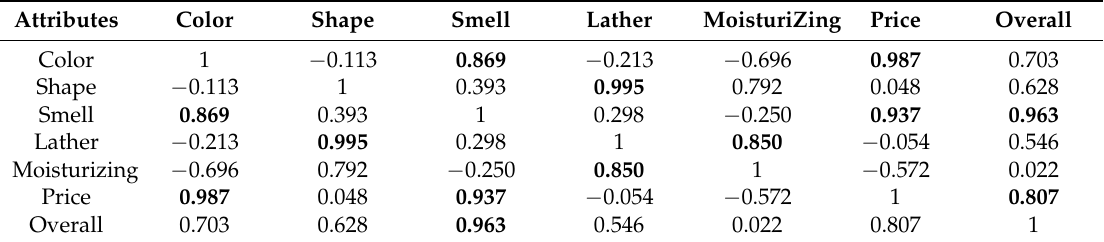
Bold values are significantly different at alpha = 0.05; n = 59 per experimental replicate.